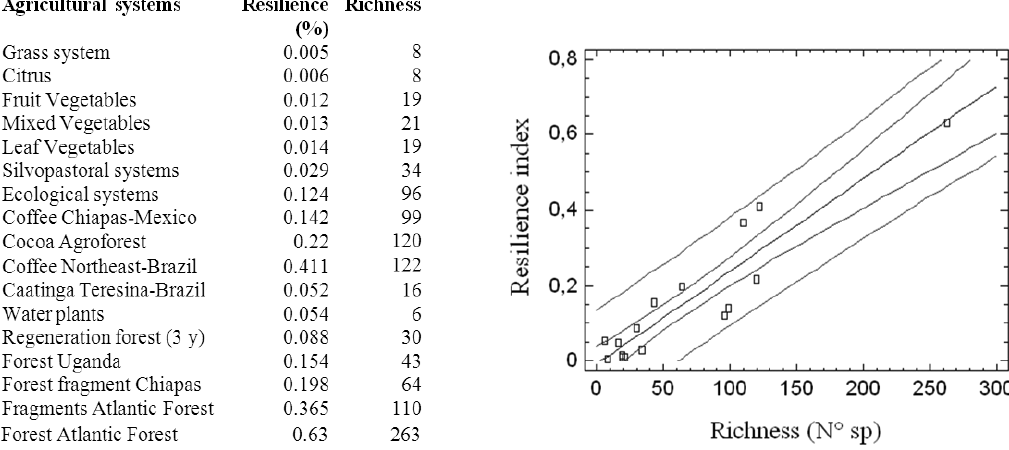
Fig. 4 – Simple Regression-Resilience index vs. Richness. The output shows the results of fitting a linear model to describe the relationship between Resilience index and Richness. The equation of the fitted model is